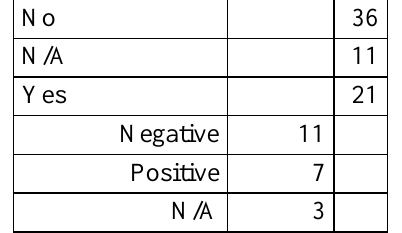
Influence of the Toolset No 36 N/A 11 Yes 21 Negative 11 Positive 7 N/A